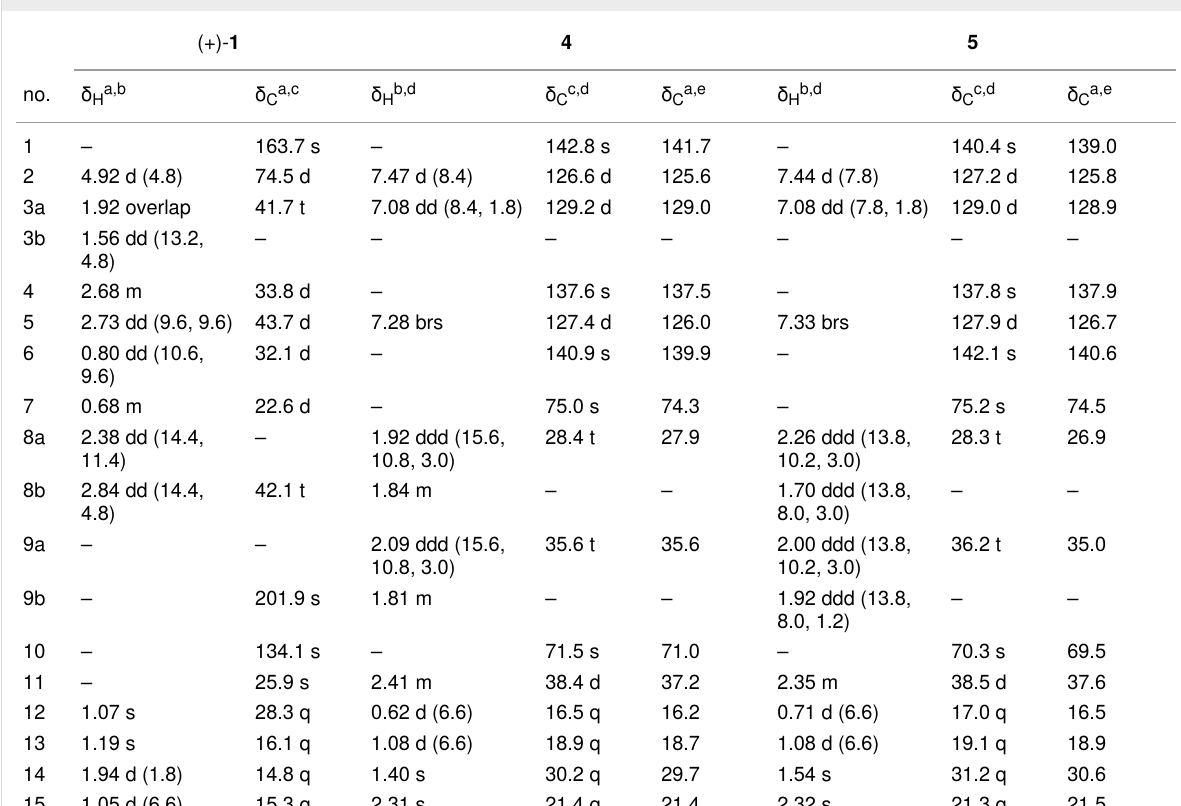
Table 1: 1 H ( J in Hz) and 13 C NMR data of compounds (+)- 1 , 4 , and 5 .